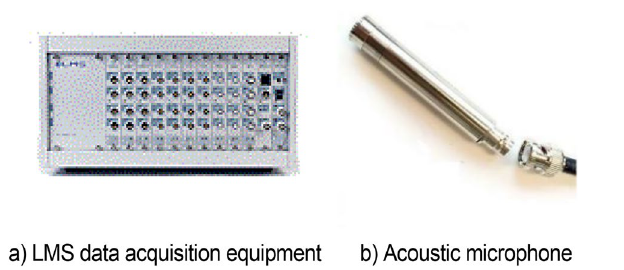
Figure 3. Acoustic acquisition